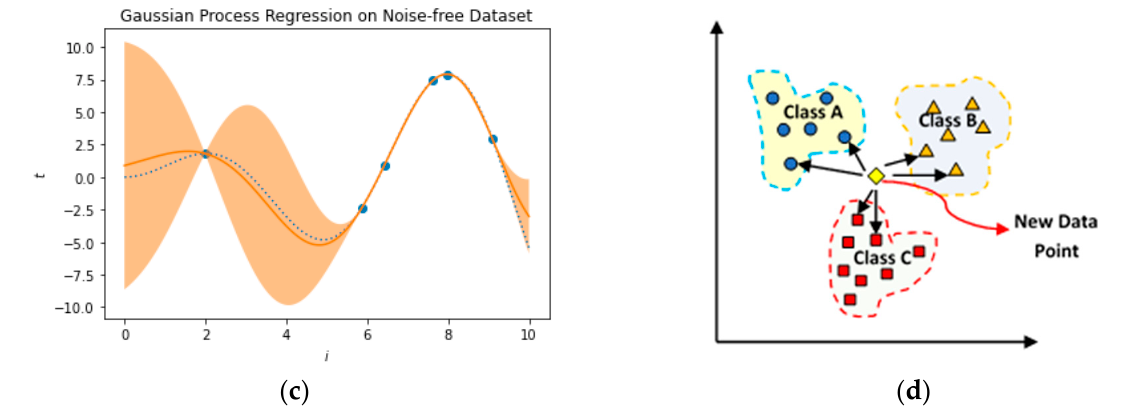
Figure 5. Visualization of the applied machine learning algorithms; ( a ) support vector machine (SVM) for regression and classification; ( b ) artificial neural network (ANN) for regression and classification; ( c ) Gaussian process regression (GPR) for regression; ( d ) k -nearest neighbor (kNN) for classi fi cation.